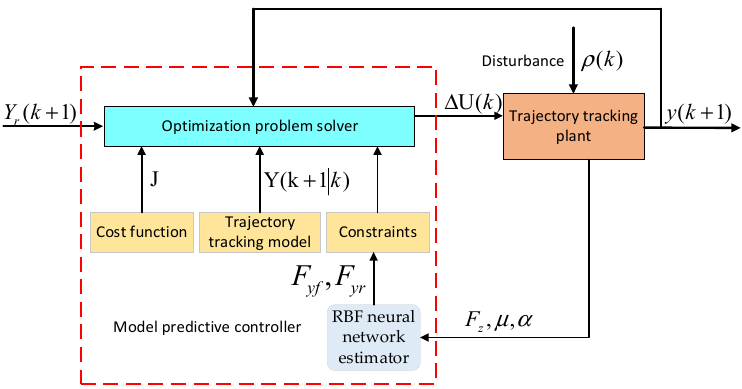
Figure 6. Schematic block diagram of the proposed MPC algorithm.